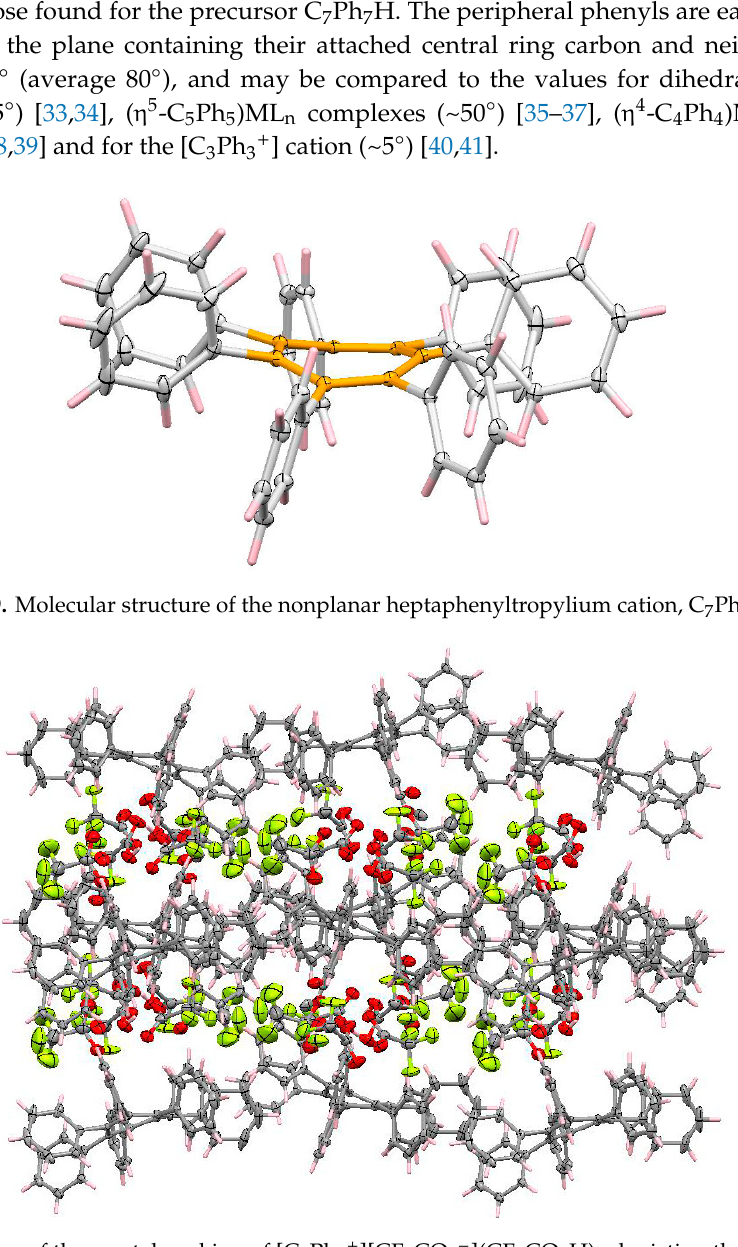
Figure 10. View of the crystal packing of [C 7 Ph 7 + ][CF 3 CO 2 − ](CF 3 CO 2 H) 2 depicting the alternating layers of cations (grey) and anions/solvates (red/yellow).